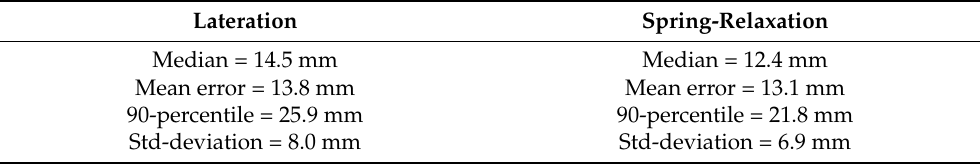
Figure 12. UIL localization accuracy error for spring-relaxation and LLS lateration. LLS: linear least square. Table 2. Localization accuracy error of the spring-relaxation algorithm compared to LLS latera- tion.